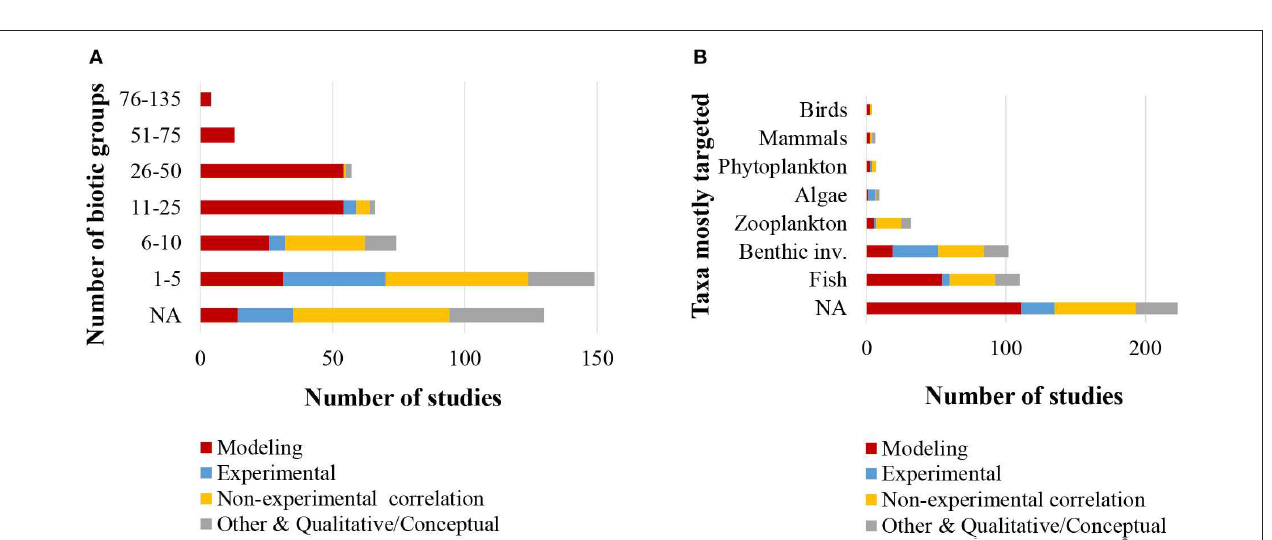
a high percentage of the studies (45%) focused in more than one taxonomic group (NA in Figure 4B ). Many studies with experimental approaches (45% of all of them) focused mostly on benthic invertebrates and –to a much lesser extent– on fish ( Figure 4B ). Of all the reviewed studies, 263 (53%) used trophic levels for the description of trophic relationships. The trophic